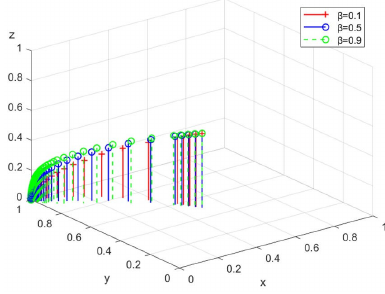
Figure 6. The path under different